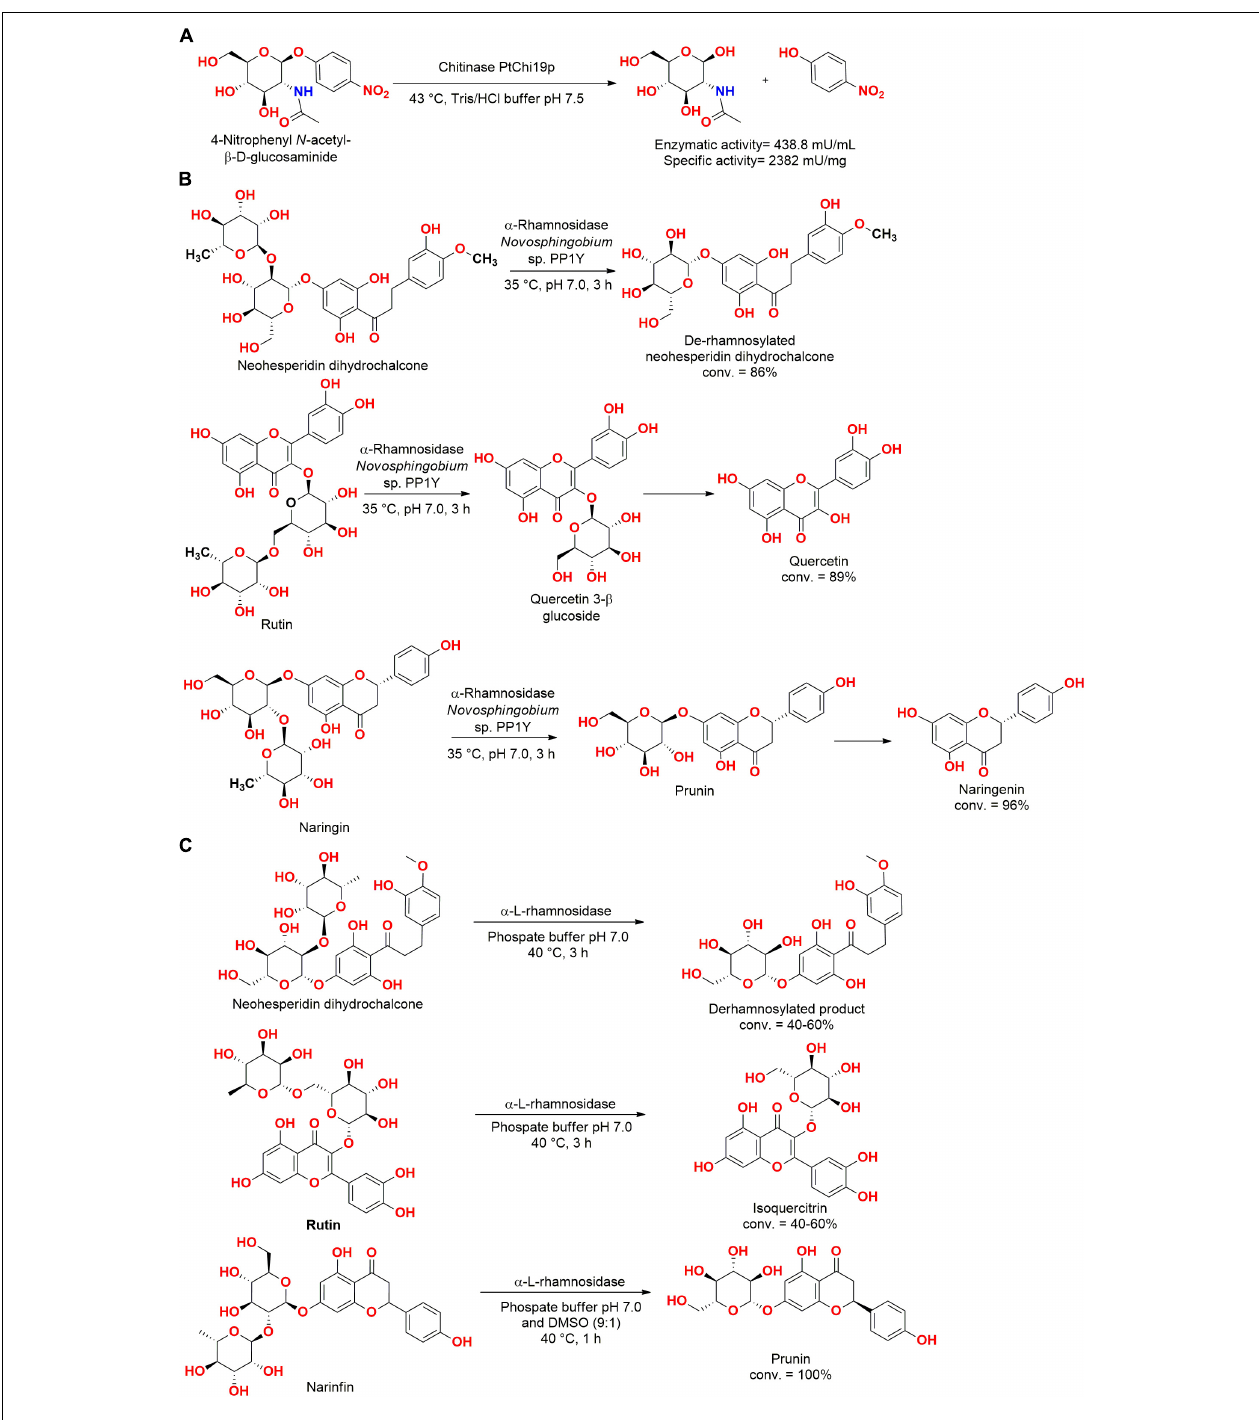
FIGURE 12 | (A) Hydrolysis of p -nitrophenyl N -acetyl- β - D -glucosaminide by the chitinase PtChi19p (Garcia-Fraga et al., 2015). (B) Hydrolysis of flavonoid glycosides by an L -rhamnosidase from Novosphingobium sp. P1Y (Izzo et al., 2014). (C) Production of glycosylated flavonoids by an α - L -rhamnosidase from Novosphingobium sp. P1Y (De Lise et al.,